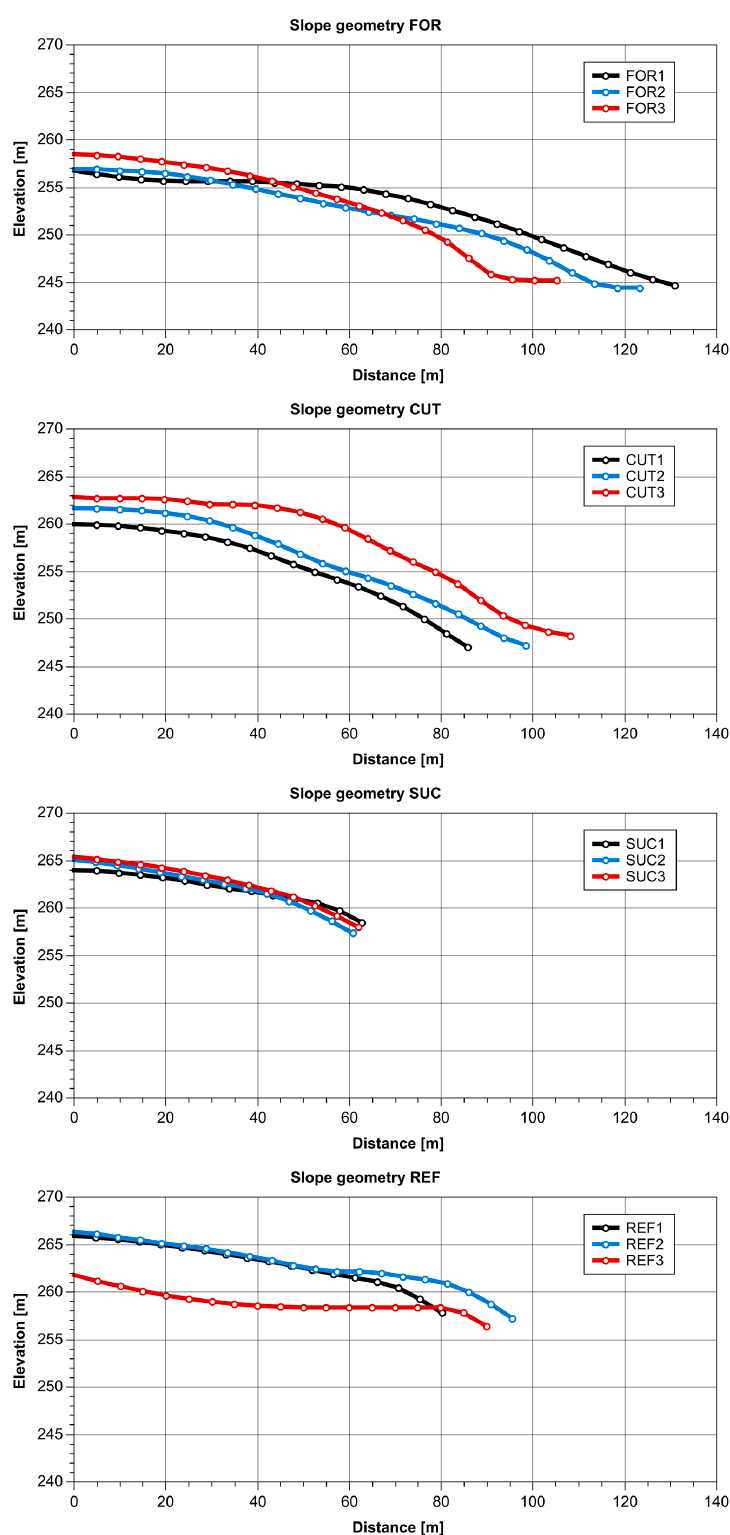
Figure 5. Slope geometry for every catena; (FOR)est, (CUT)-down, (SUC)cession, (REF)forested. Catena length was limited by pumice deposit extension and therefore by the extent of slope that is a ff ected by excavation works. A tabular overview shows slope length and mean sloping of the observed catenae (Table